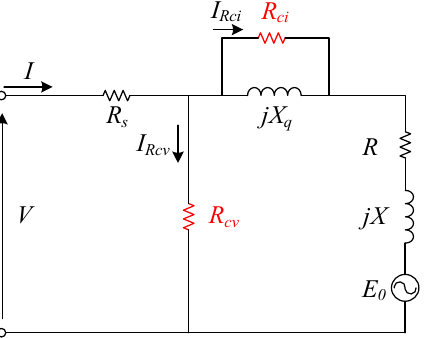
Figure 7. Per-phase ECM with predictable core loss of PMSMs [11].